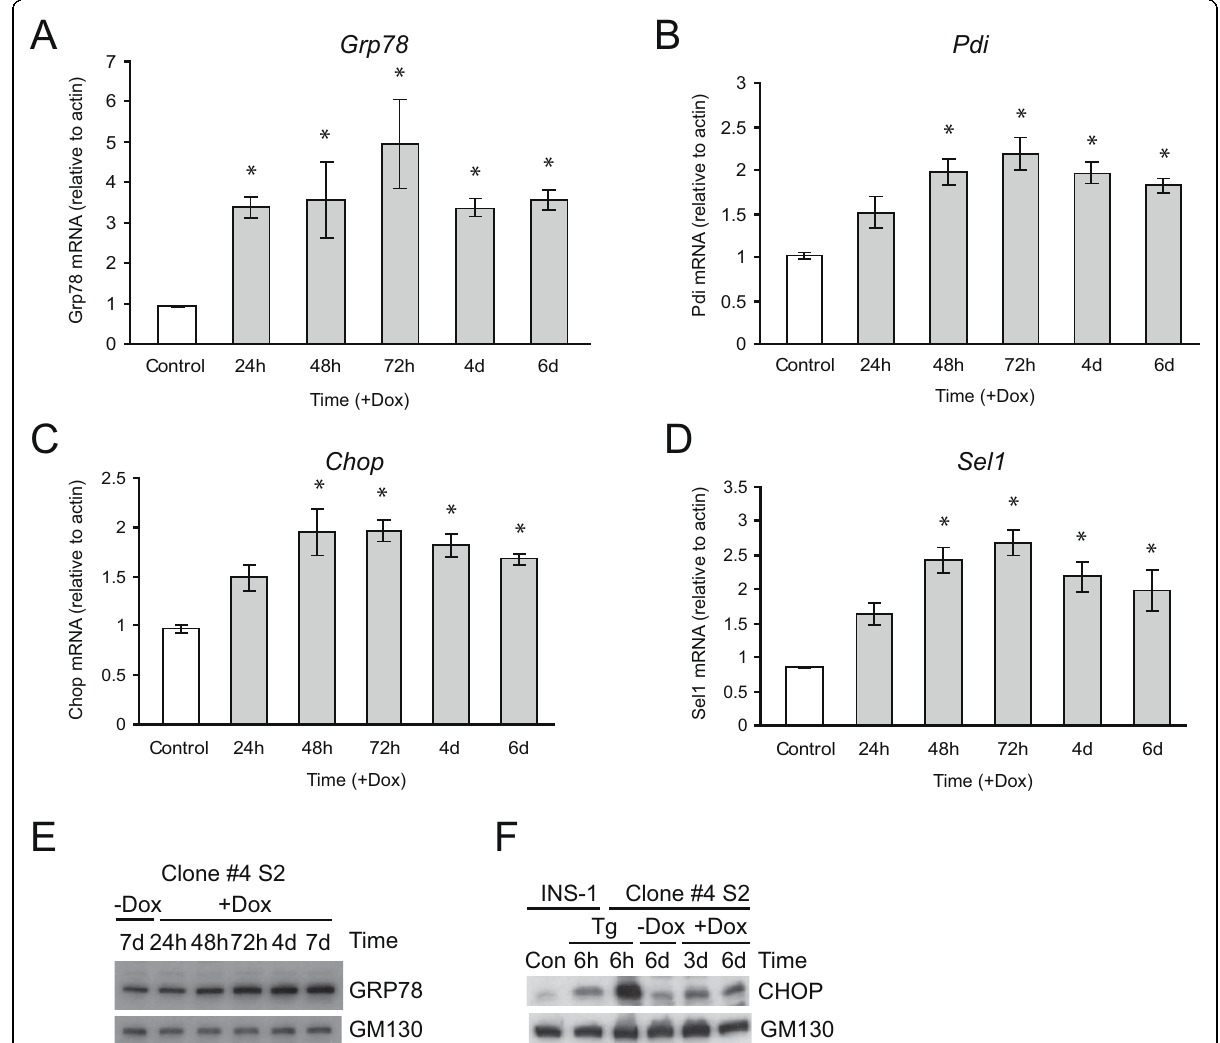
Figure 5 Expression of insulin 2 (C96Y)-EGFP induces the mRNA and protein of known ER stress response genes . Clone #4S2 cells were untreated (Control) or treated with 2 μ g/ml doxycycline (+Dox) for the times indicated (h, hours; d, days). A-D . Total RNA was isolated and the mRNA levels relative to cellular b -actin for Grp78 (A), Pdi (B), Chop (C), Sel1 (D) were analyzed by real-time PCR as outlined in the methods. Shown are the mean ± SE of 3 independent experiments. *p < 0.05 relative to control. E, F . Clone #4S2 cells were treated as described above, washed in PBS, lysed and equal amounts of protein were resolved by SDS-PAGE and immunoblotted as indicated. Control INS-1 cells exposed to thapsigargin (Tg) were used as a positive control in